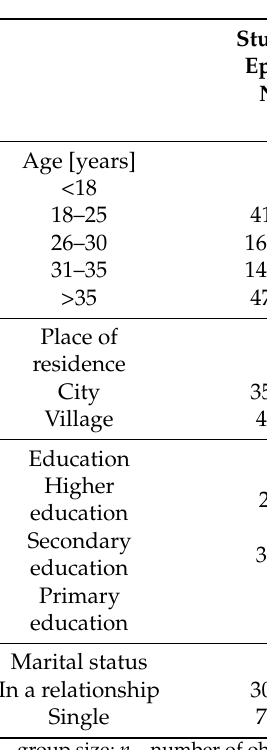
Table 1. Characteristics of the